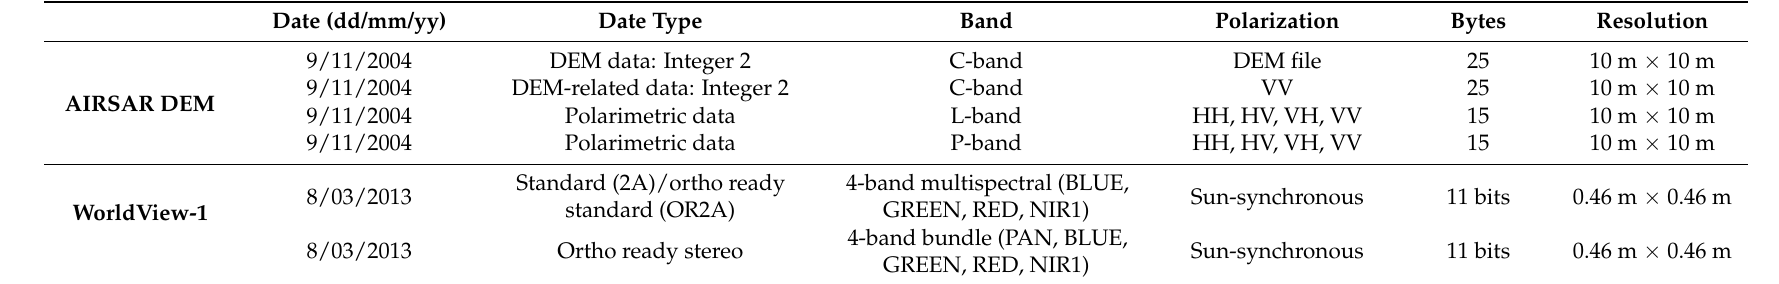
Table 1. Characteristics of AIRSAR DEM data and WorldView-1 satellite imagery used in the